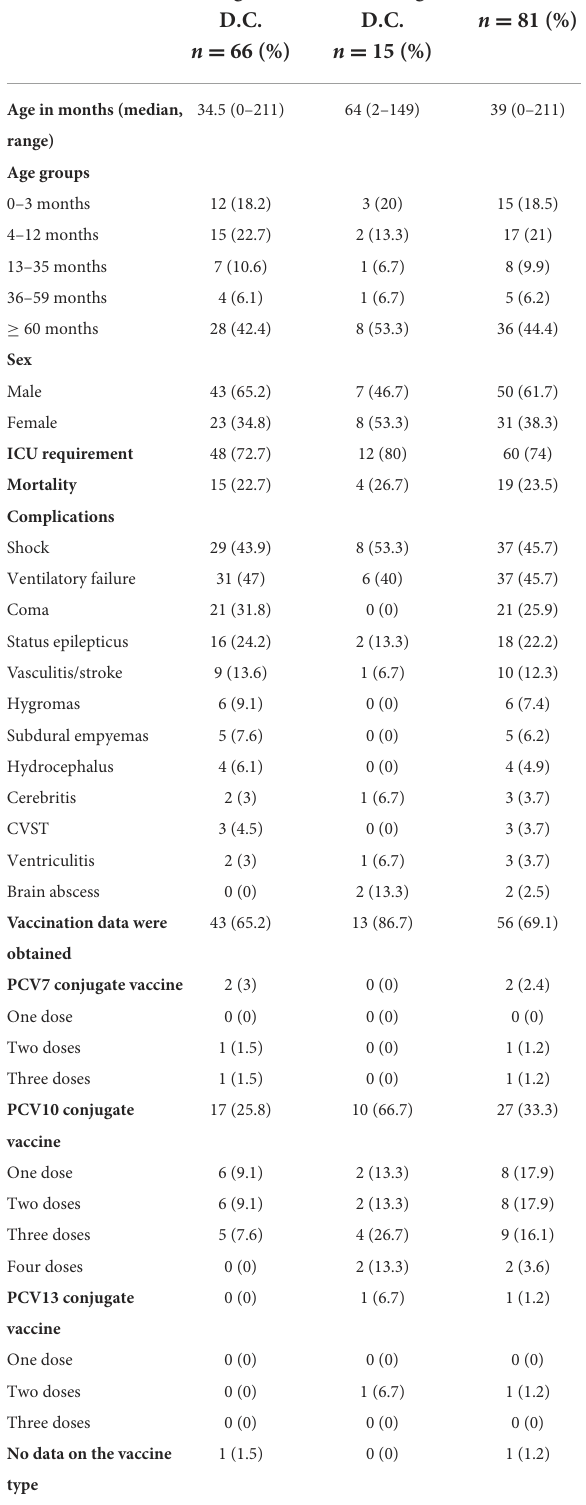
TABLE 1 Demographic and clinical characteristics of patients with pneumococcal meningitis.